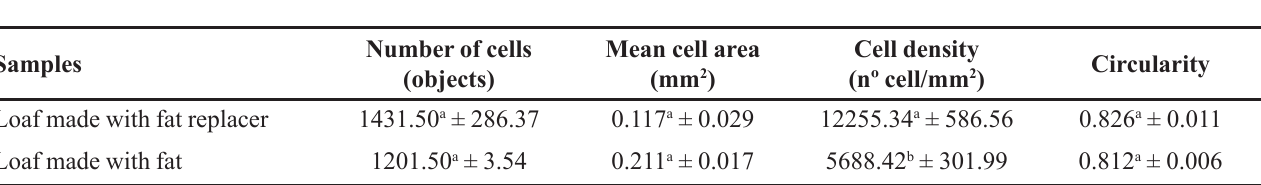
TABLE IV - Image analysis parameters of bread loaves Samples Circularity